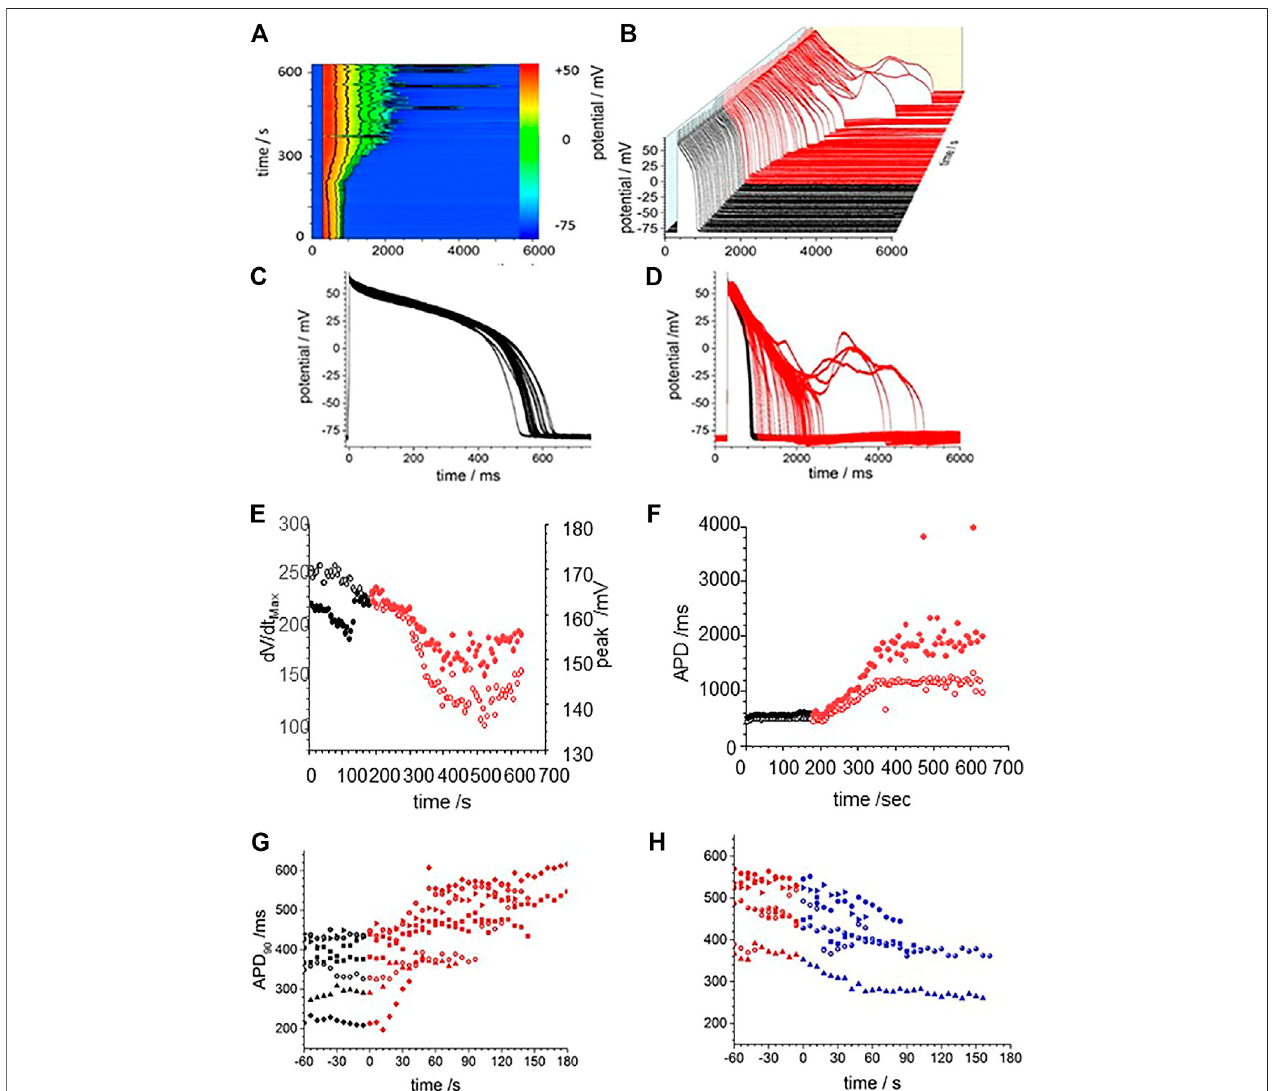
FIGURE 3 | CO prolongs action potentials of isolated guinea-pig ventricular myocyte. (A) Color map of membrane potential during 105 cycles of pacing, with BCL of 6 s (B) staggered plot of V(t) during these action potentials. Black before effect of CO, red during development of effect of CO. CORM2 was perfused into the bath supplylineattime180 s (C) Intrinsic fl uctuationsinAPD 90 beforeeffectofCO. (D) SuperpositionofevokedactionspotentialsbeforeandduringCORM2.Timeseriesplot of (E) peak depolarization ( fi lled symbols) and dV/dt max (open symbols) measurements and (F) ; APD 50 (open symbols and APD 90 ( fi lled symbols) before (black symbols) and during (red symbols) the response to perfusion by CORM-2. (G) APD 90 during application of CORM-2 and (H) NS1643, starting with last 10 action potentials before perfusion with CORM-2, and during perfusion with NS1643.